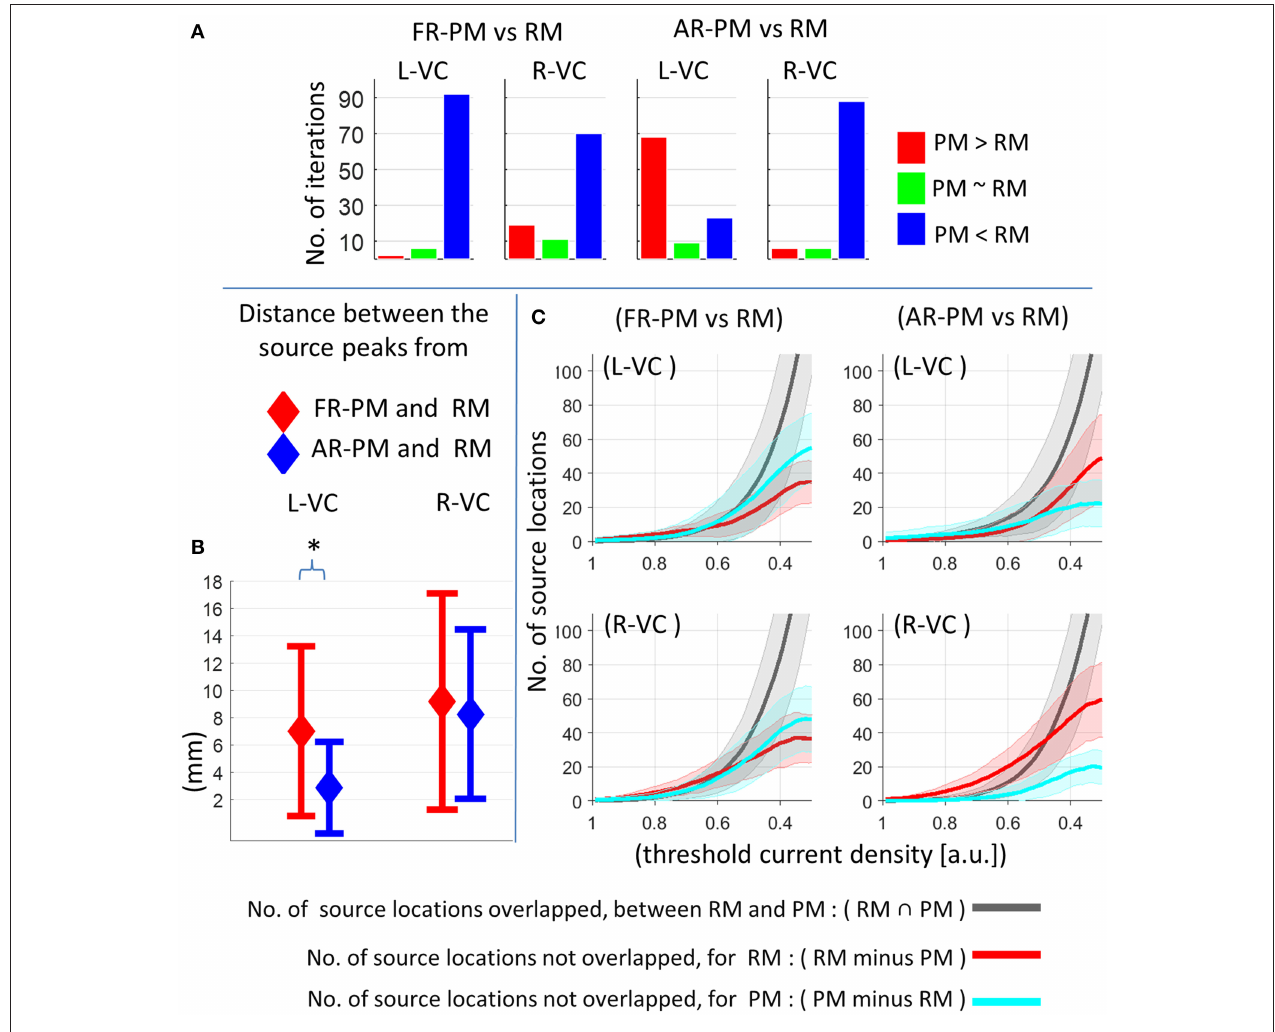
FIGURE 6 | Comparison of functional group source ERP response between pseudo MRI and real MRI for 20 subjects in a group and 100 group iterations. (A) Comparison of peak source ERP magnitude for different group iterations. Y-axis represents number of group iterations showed significant difference for peak source ERP magnitude ( p < 0.01: blue and red bar, p > 0.01: green bar, bootstrap approach ). (B) Peak source localization error across the group iterations (mean ± standard deviation). * p < 0.01, Wilcoxon signed-rank test, n = 100 group iterations. (C) Overlap of activation region (no. of grid point locations) between real MRI and pseudo MRI after applying different levels of threshold value across the group iterations (mean ± standard deviation). RM, real MRI; PM, pseudo MRI; FR-PM, first rank pseudo MRI; AR-PM, averaged rank pseudo MRI; L-VC, left visual cortex; R-VC, right visual cortex; a.u., arbitrary unit where a.u. = 1 corresponds to maximum source ERP value for a given group iteration in visual cortex for real